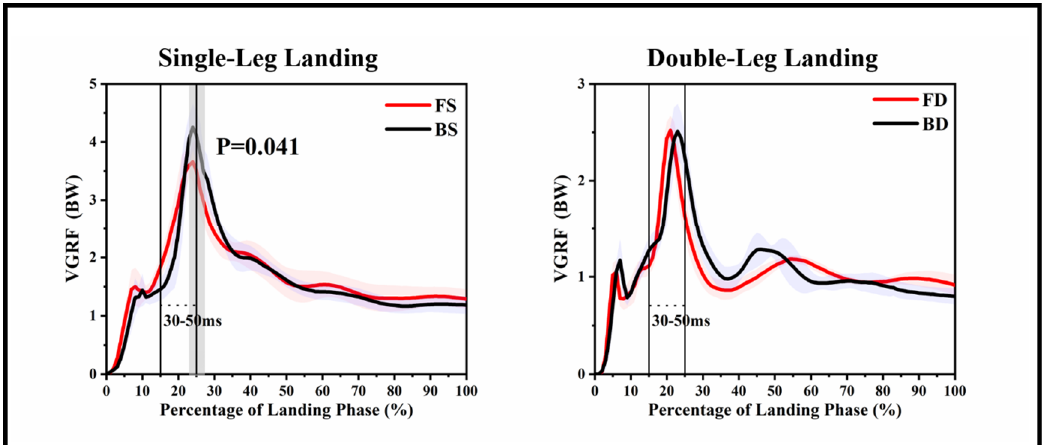
Figure 3. Descriptive results between forward landing and backward landing task statistical parametric mapping results, depicting the VGRF of single-leg landing and double-leg landing mean forces trajectories and standard error. The range of the two lines is the time frame between 30 and 50 ms time after landing. Gray shaded areas are statistically different ( p < 0.05) between forward landing and backward landing during the landing phase. FS: forward single-leg landing; FD: forward double-leg landing; BS: backward single-leg landing; BD: backward double-leg landing. Table 2. The peak vertical ground reaction force (VGRF) and vertical instantaneous loading rate (VILR) during the landing phase between forward landing and backward landing. Table 1. The hip peak joint angle and range of motion (ROM) of the joint angle during the landing phase between forward landing and backward landing. FS BS p FD BD p Peak Vertical Ground Reaction Force (BW) Vertical Instantaneous Loading Rate (BW /